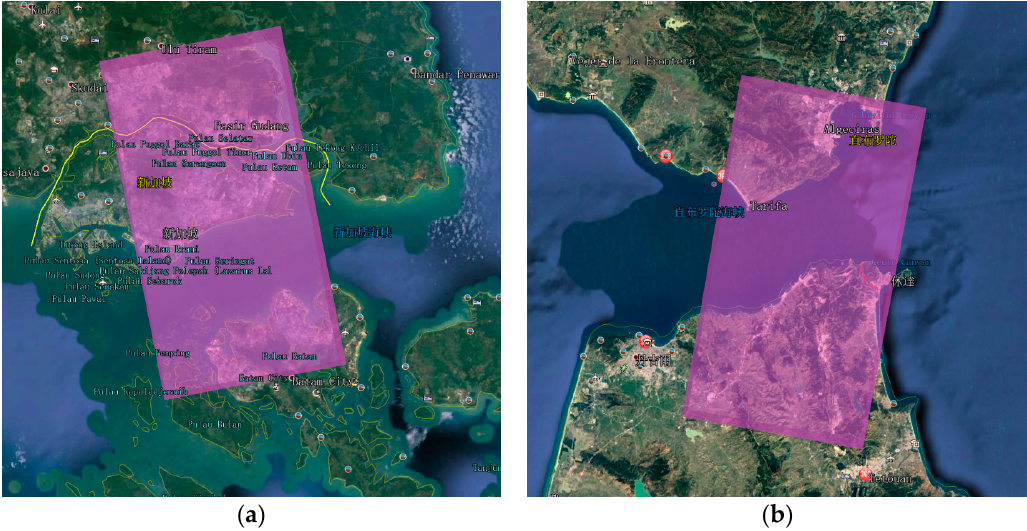
Figure 9. Two optical remote-sensing images. ( a ) is the Strait of Singapore; ( b ) is the Strait of Gibraltar. The fuchsia area is the TerraSAR-X sensor imaging